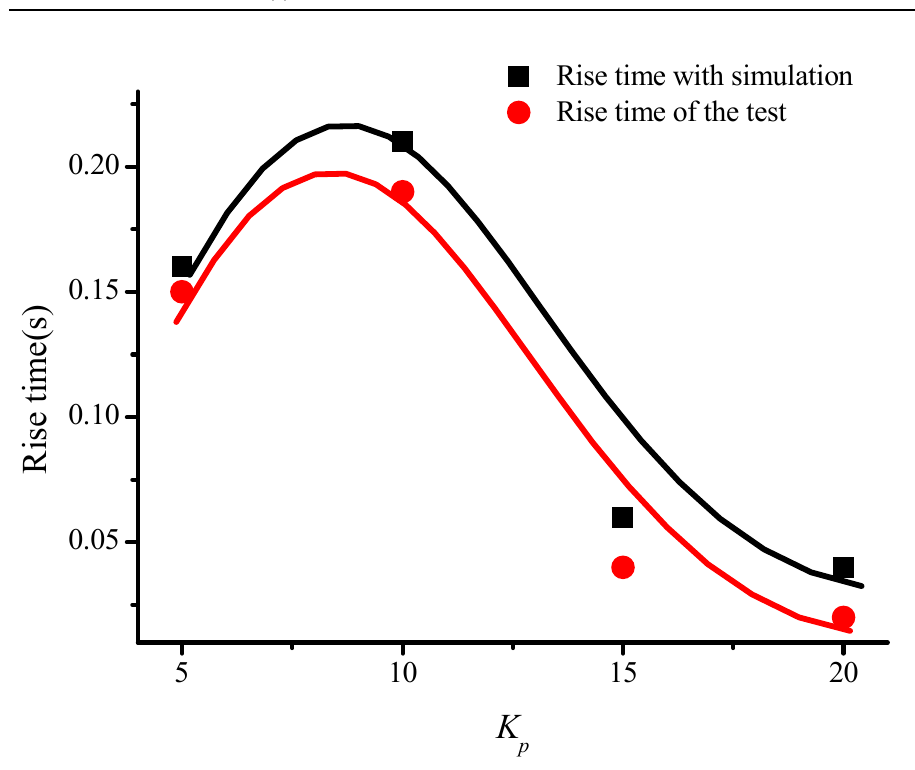
Figure 12. Comparison of simulation and test results when K p changed.